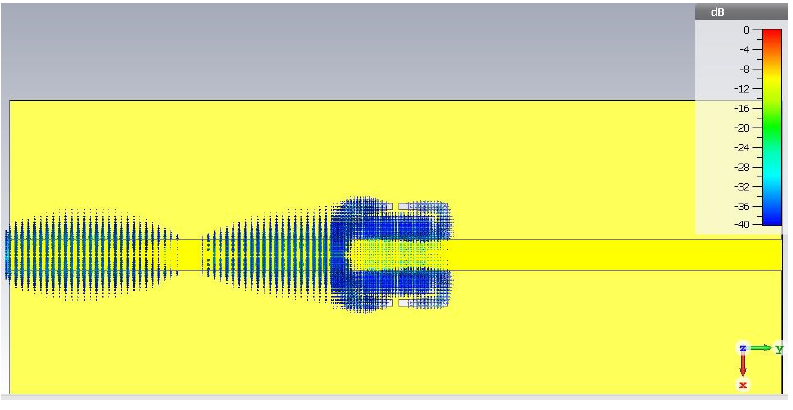
Figure 7. E-field at resonance